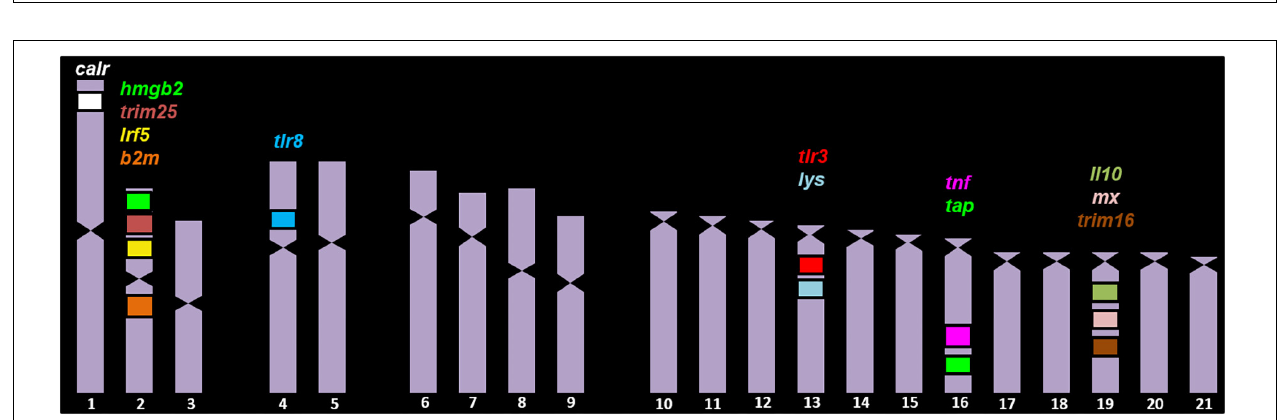
FIGURE 1 | Results of mFISH of the BACs isolated with the following candidate genes: (a) tlr8 (blue), lysg (green), tap1 (pink), tnf α (orange); (b) irf5 (blue), calr (green), b2m (red); (c) trim 16 (green), mx (orange), calr (pink); (d) irf5 (blue), tlr3 (green); tnf α (orange), mx (pink); (e) hmgb2 (blue), lysg (green), b2m (pink); (f) trim25 (blue), tnf α (green), tap1 (orange), b2m (pink); (g) il10 (blue), tnf α (green), tap1 (orange), b2m (pink). In those cases where two or more probes co-localize in one chromosome, a diagrammatic representation is included.